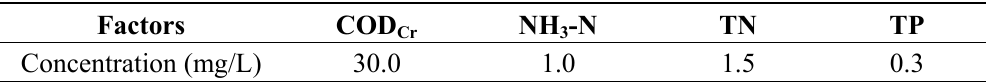
Table 8. Water quality objectives of the Hongqi River.